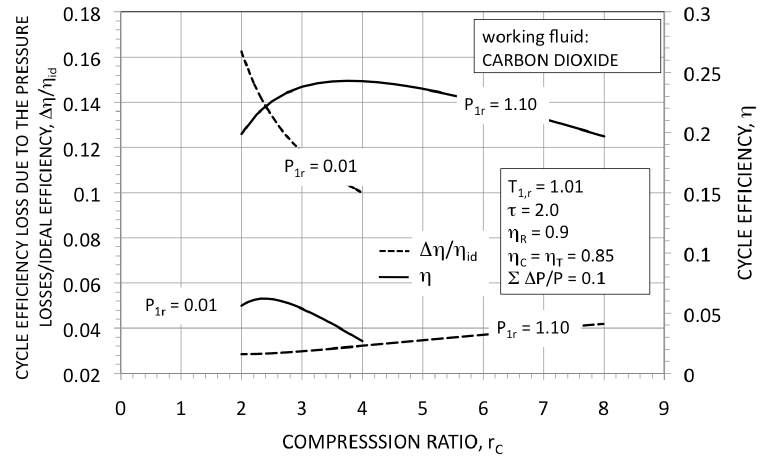
Figure 7. Cycle thermodynamic efficiency losses due to the pressure losses and cycle efficiencies as a function of the compression ratio. For simplicity, the pressure losses Σ∆ P / P = 0.1 were concentrated after the compressor